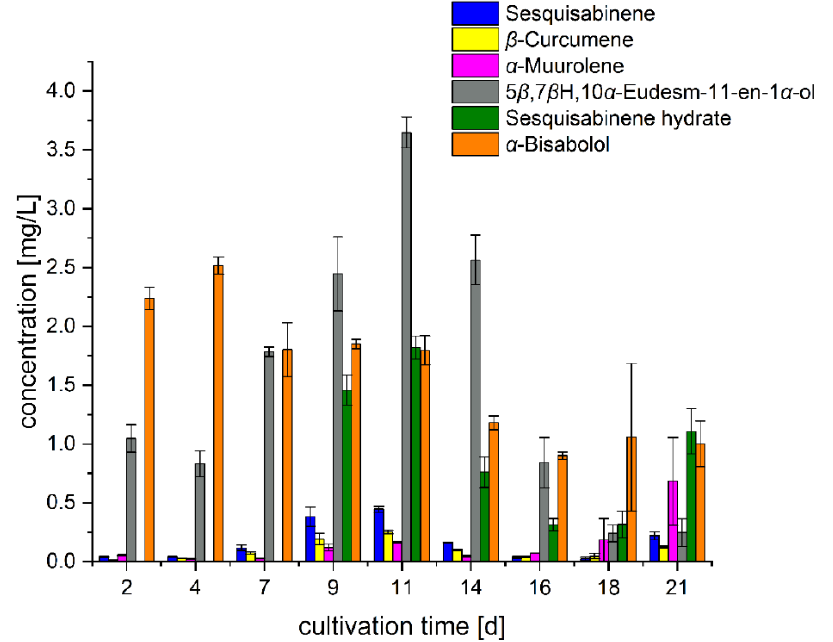
Figure 2. Sesquiterpenoid production over 21 days during the submerged cultivation of Cerrena unicolor